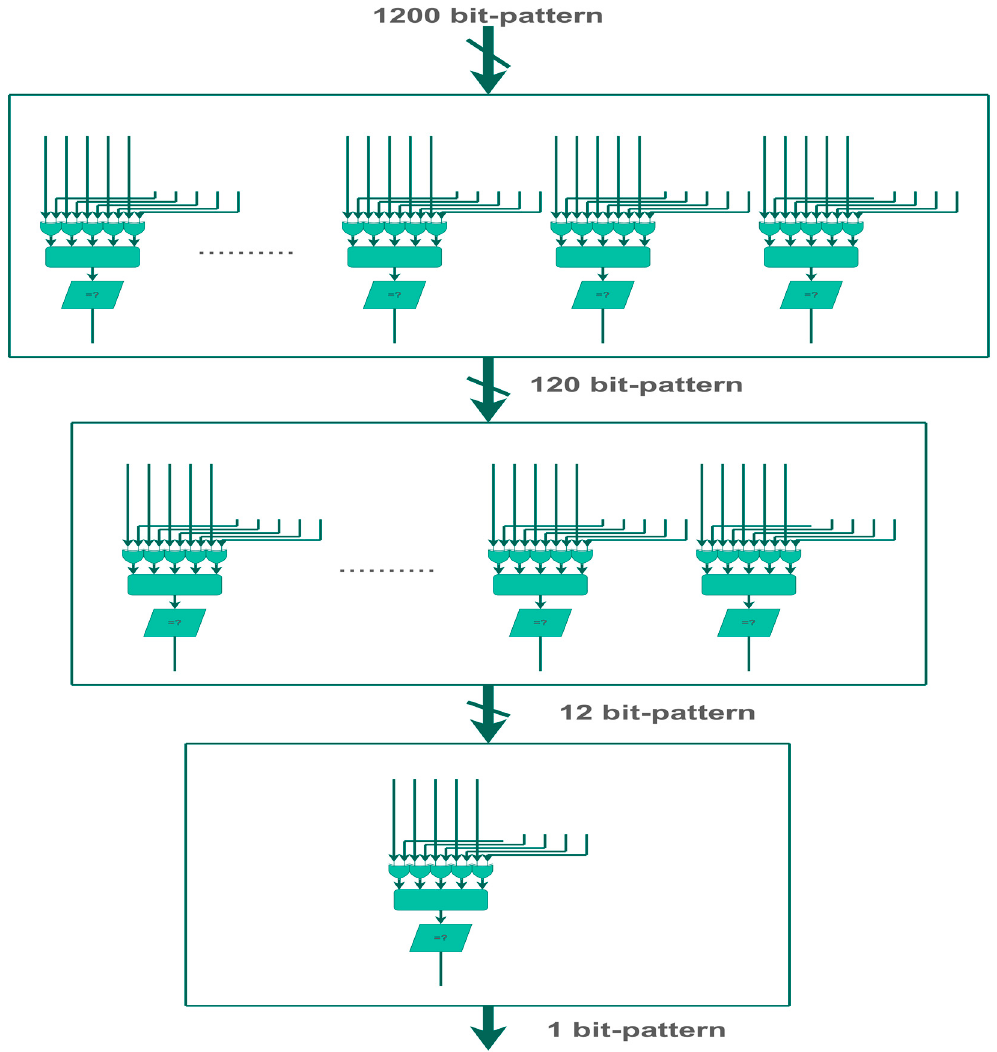
Figure 4. The 3-stage cascaded pattern